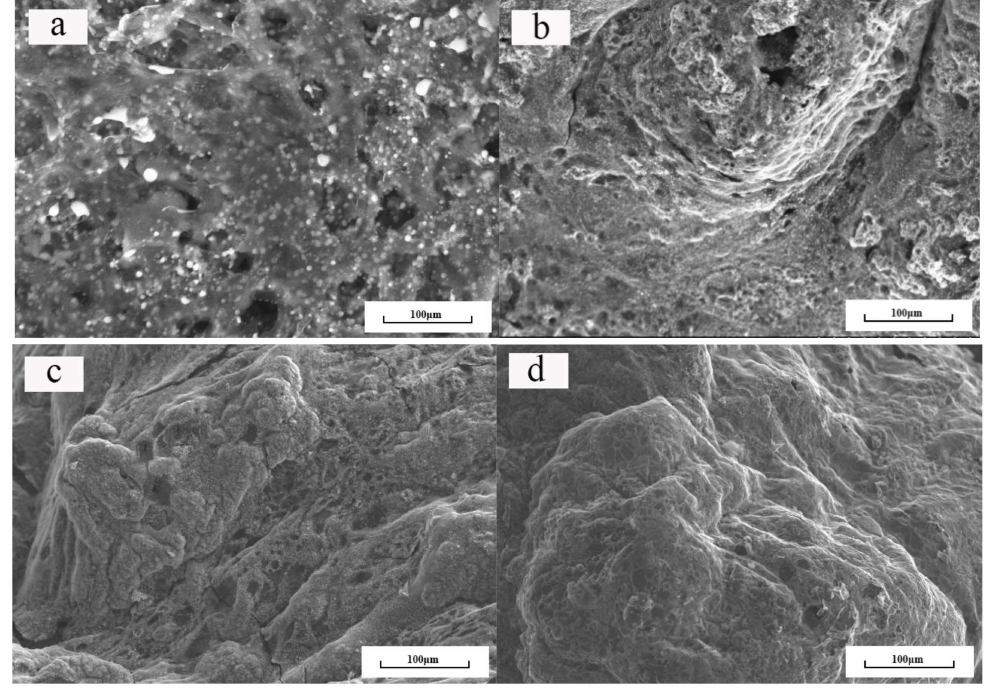
Figure 7. Scanning electron microscopy (SEM) micrographs of chars after the LOI test. ( a ) EP0; ( b ) EP1;